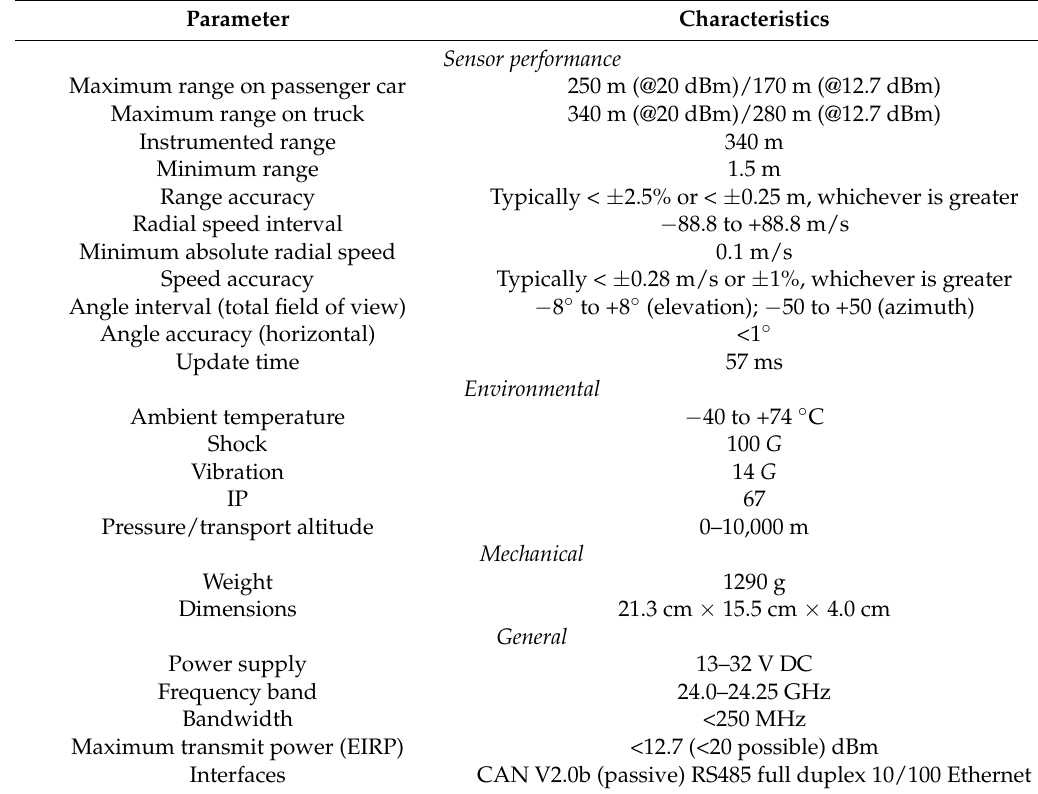
Table 4. Specifications of the UMRR 0C Type 42 anti-collision